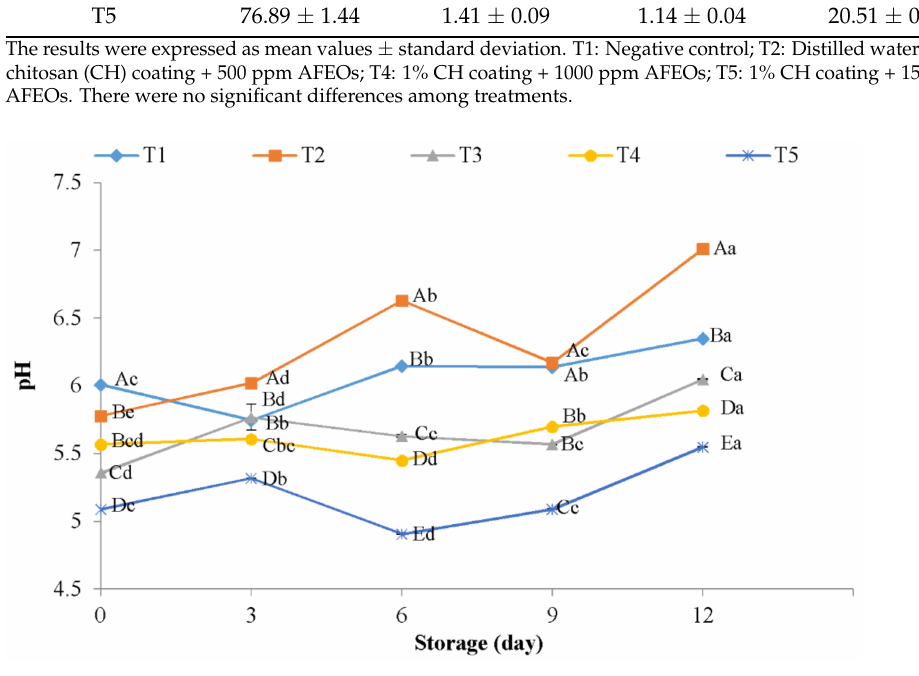
Figure 1. pH values of chicken meat coated with chitosan containing AFEOs during refrigerated storage. T1: Negative control; T2: Distilled water; T3: 1% CH coating + 500 ppm AFEOs; T4: 1% CH coating + 1000 ppm AFEOs; T5: 1% CH coating + 1500 ppm AFEOs. a–d Mean values during